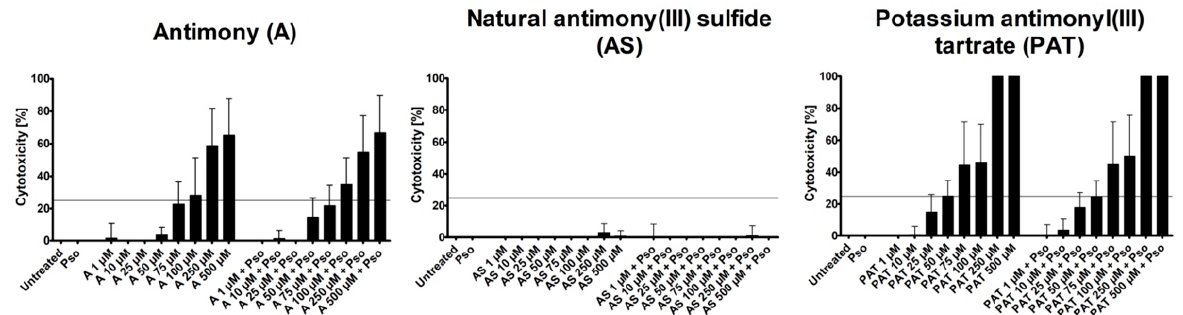
Figure 1. LDH assay to determine cytotoxicity of ACs. PHKs were treated with increasing concentrations of A, AS and PAT for 24 h alone or in addition to stimulation with Pso (20 ng/mL of IL-17A, IL-22 and TNF- α ). Afterwards, cell culture supernatants were collected and LDH release was analyzed. Results are shown as mean ± SD of three independent experiments.